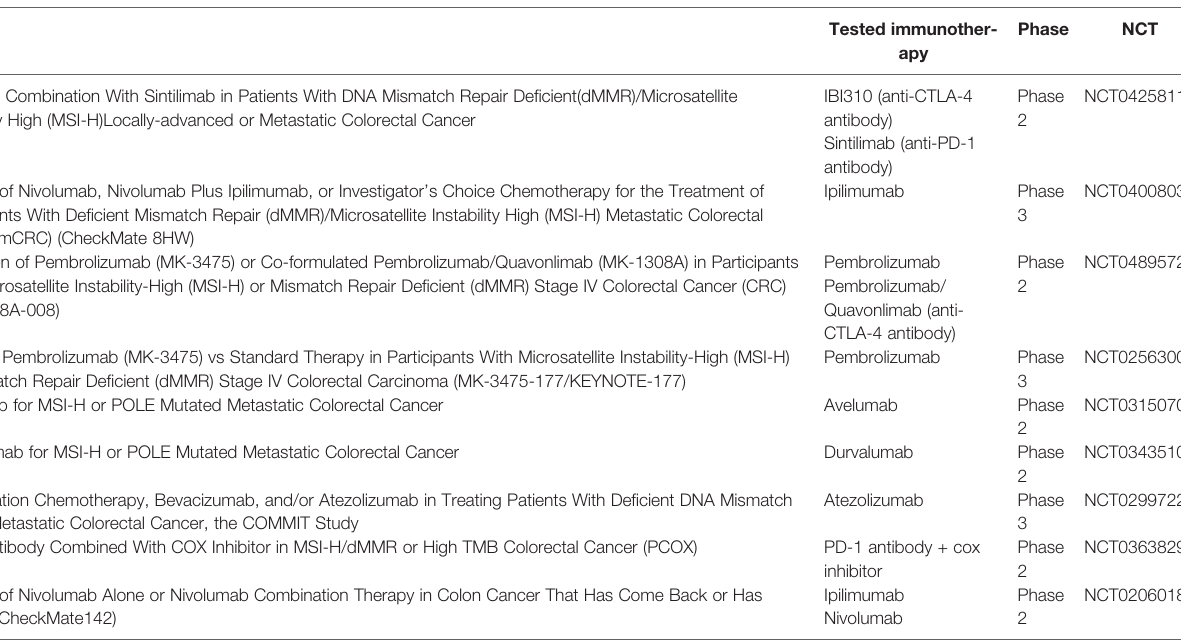
TABLE 1 | Ongoing clinical trials for dMMR/MSI-H mCRC using immunotherapy.